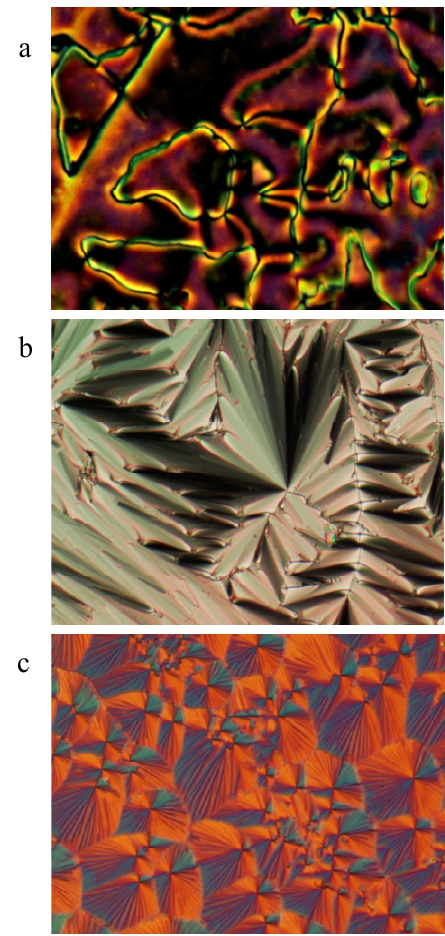
Figure 3. Polarized optical micrographs of 7 O- PPPyCN arise from isotropic phase on cooling to ( a ) 246 °C, nematic Schlieren texture, ×400; ( b ) 162 °C, smectic A texture, ×200; ( c ) 148 °C, smectic C texture,